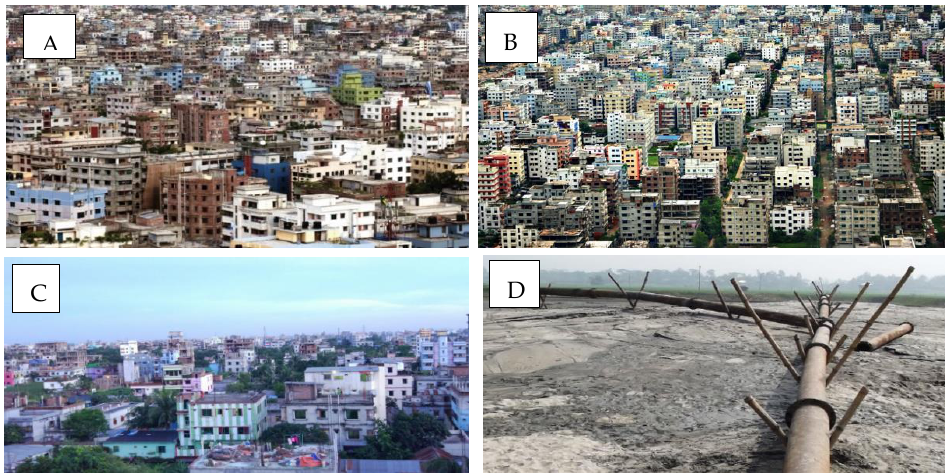
Figure 2. ( a ) Highly dense built-up area and informal settlement in the Dhaka South City Corporation (DSCC), ( b ) relatively less congested buildings and formal settlement in the Dhaka North City Corporation (DNCC), ( c ) built-up area with vegetation in the fringe area, and ( d ) sand filling for land development in the fringe